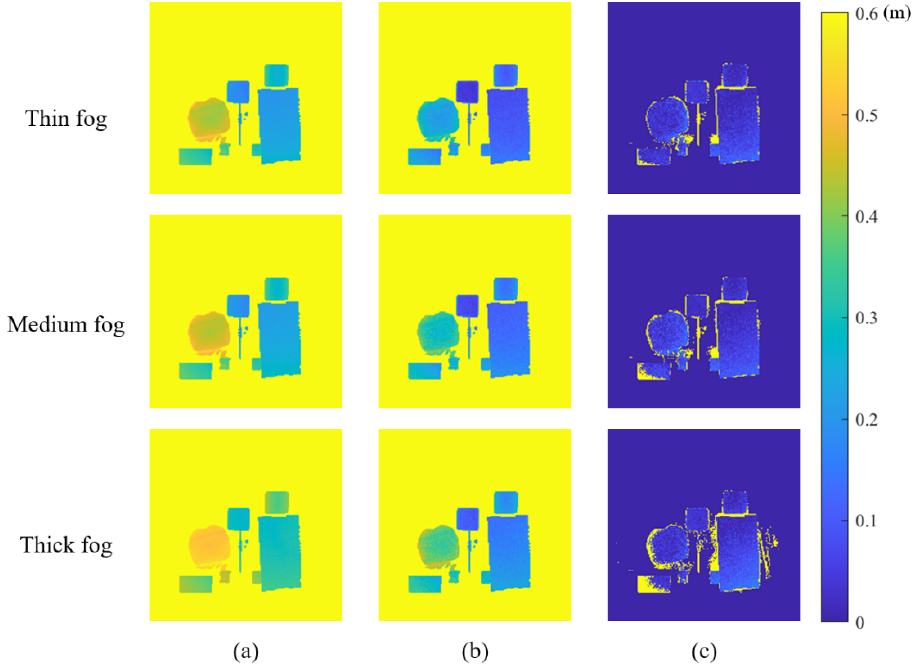
Figure 10. Absolute error of depth under different thicknesses of fog. ( a ) The absolute error of the image captured by an ordinary ToF camera at θ || . ( b ) The absolute error of the image captured by an ordinary ToF camera at θ ⊥ . ( c ) The absolute error of the image recovered by our method.